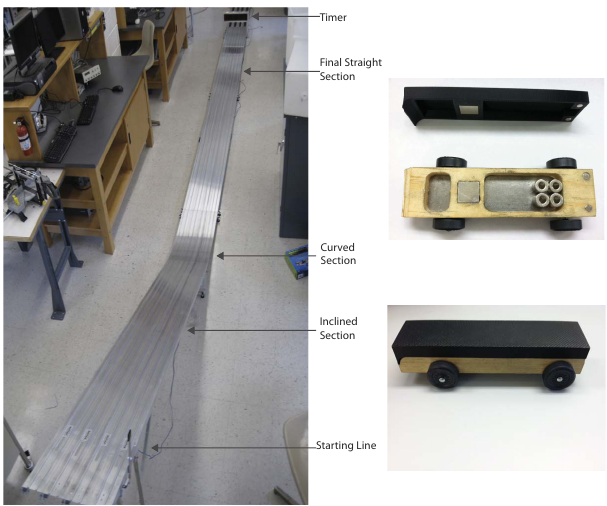
Figure 11. Experimental track and car body used during the ex- perimental investigations. The outer shell of the car is removable to allow for trials with di ff erent masses and centers of